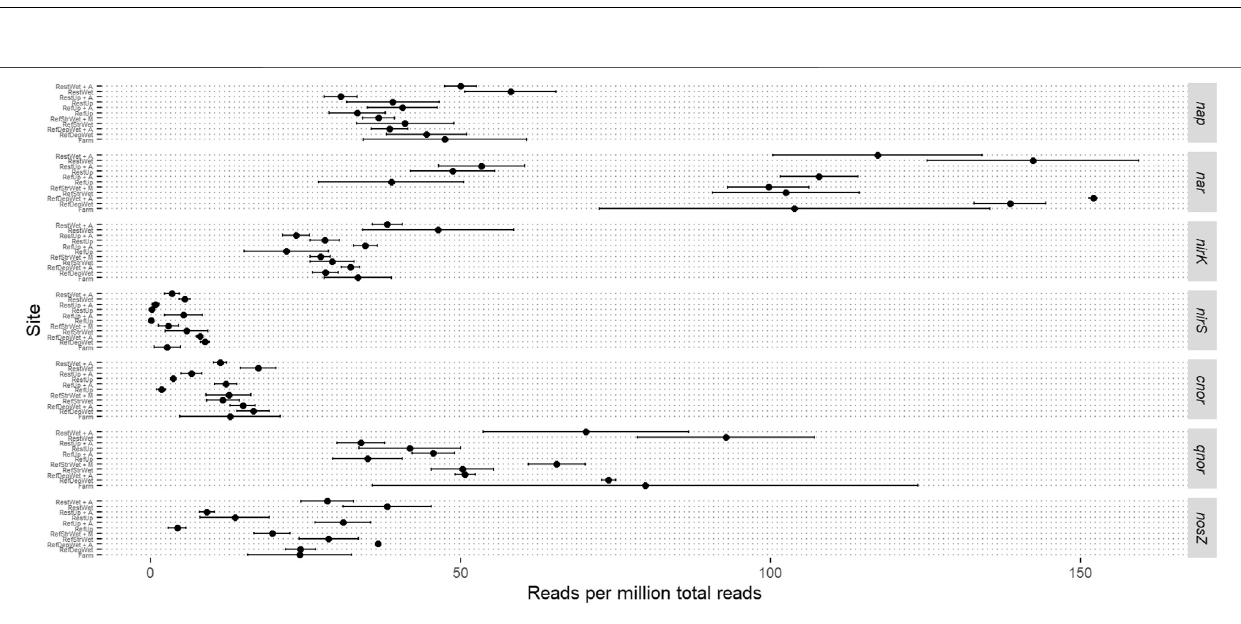
FIGURE 4 | Mean read abundance from individual denitri fi cation genes. Sample abbreviations are: RestUp – Restored Upland, RefUp – Reference Upland, RestWet – RestoredWetland,RefStrWet – ReferenceStreamsideWetlandandRefDepWet – ReferenceDepressionalWetland.Errorbarsrepresentonestandarddeviation from the